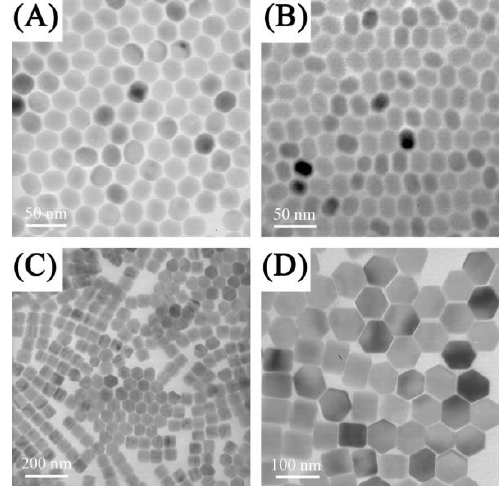
Figure 4. TEM images of NaYF :Yb 3+ , Er 3+ nanospheres ( A ), nanoellipses ( B ), nanoplates ( C , D 4